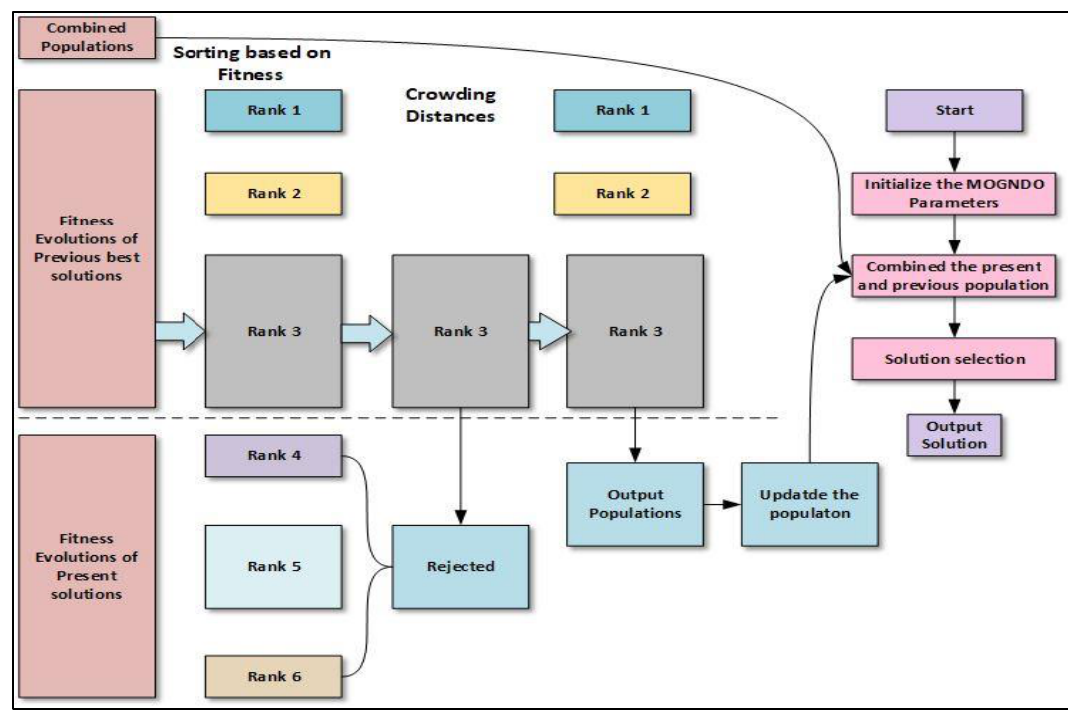
Figure 10. The procedure of the non-dominated sorting approach.